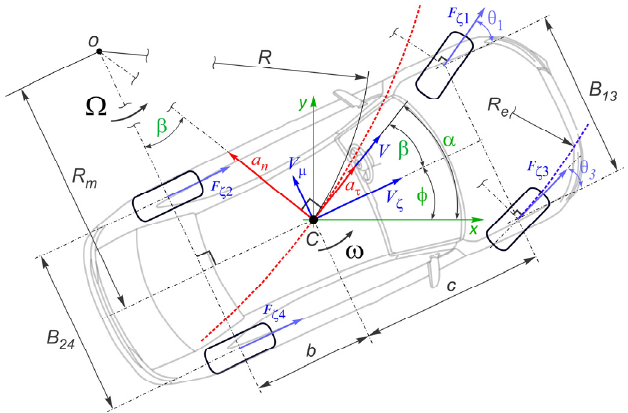
Figure 4. Scheme of forming the mass center’s trajectory, based on the ideal vehicle kinematics